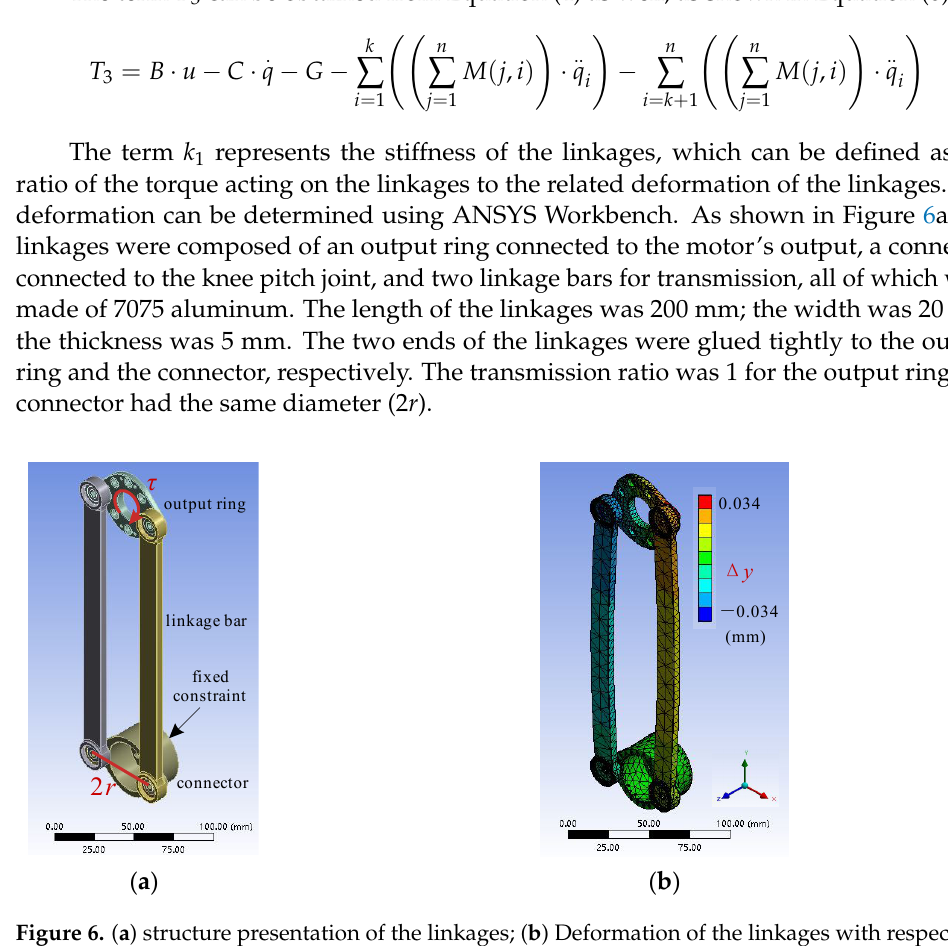
Figure 6. ( a ) structure presentation of the linkages; ( b ) Deformation of the linkages with respect to a certain torque.